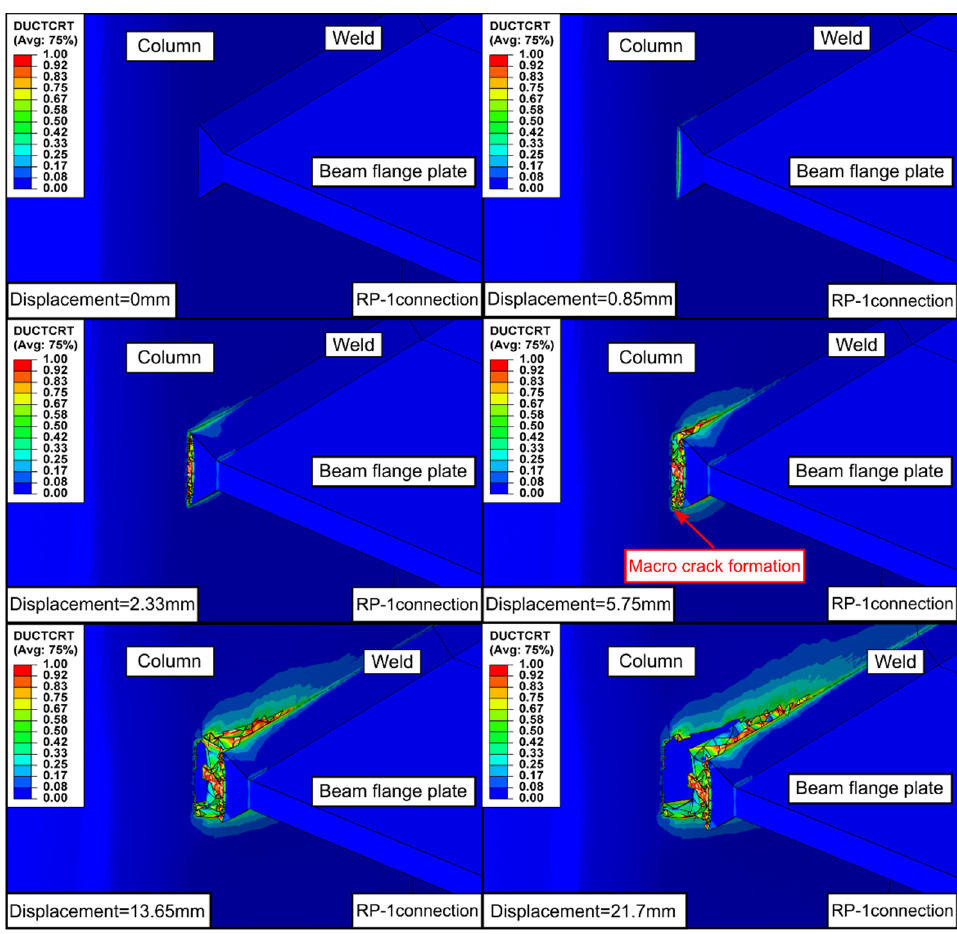
Figure 9. Fracture initiation and crack propagation of the RP-1 specimen simulated from the new fracture model.